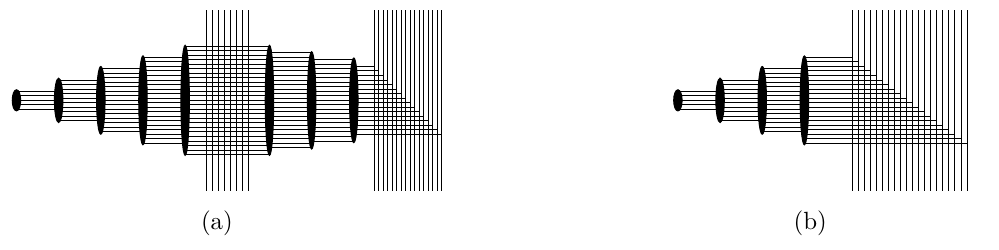
Figure 4. Left: 3d quiver (3.2) for N 5 = 8 , K = 1 . Right: 3d quiver (3.8) for N 5 = 4 , K = 3 . As in figure 2, NS5-branes are shown as ellipses, D3-branes as horizontal lines, and D5-branes as vertical